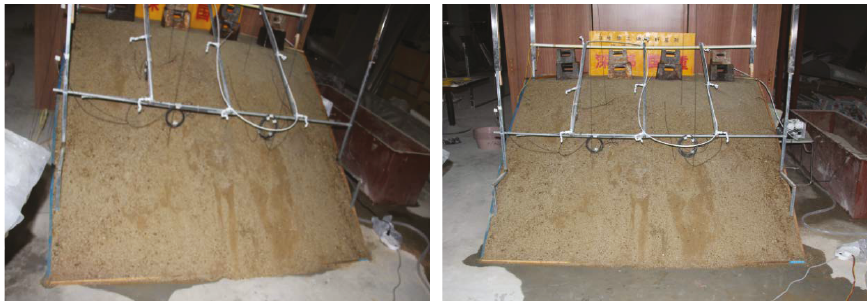
Figure 11: Fiber optic strain experiment under di ff erent rainfall